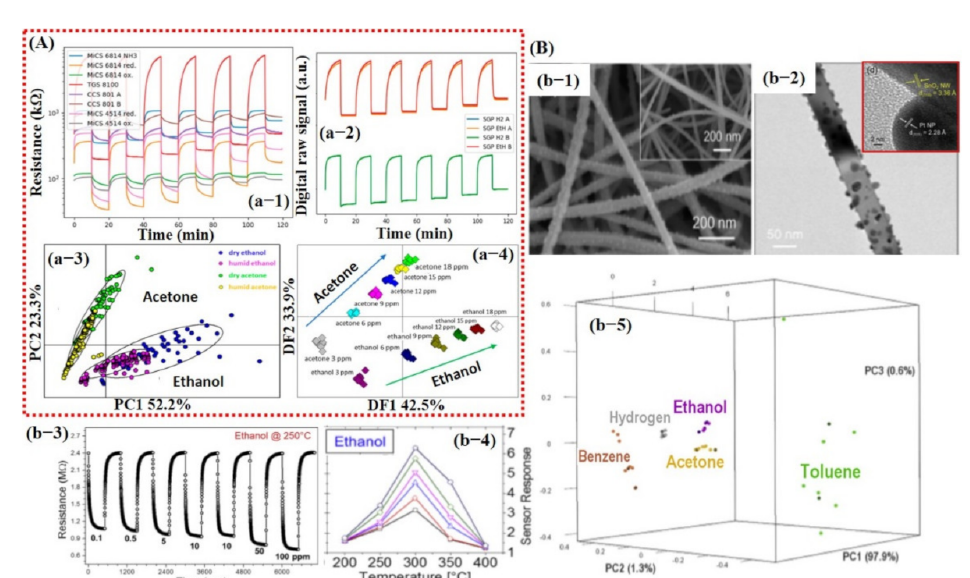
Figure 14. ( A ) e-nose system consisting of analog and digital sensors for detection of different compounds: (a-1) Raw data of analog sensors to acetone under humid conditions. (a-2) Raw data of digital sensors after exposure to acetone under humid conditions. (a-3) PCA score plot showing the effect of humidity. The measurements are labeled by condition and target compound. (a-4) LDA scores plot for the discrimination of compounds and concentrations of the measurements performed under dry and humid conditions. Reproduced with permission from [132], copyright 2019 ACS. ( B ) Smart sensing of different compounds using thermal fingerprints of a single sensor based on Pt NPs@SnO 2 NWs. (b-1) SEM image of Pt NPs decorated on SnO 2 NWs. (b-2) Higher magnified TEM image of single SnO 2 NW decorated with Pt NPs. (b-3) Dynamic response during the exposure of different ethanol concentrations @ 250 ◦ C. (b-4) Sensor response to ethanol at different operating temperatures. (b-5) Three-dimensional plot of the principal components revealing excellent discrimination among different compounds. Reproduced with permission from [133], copyright 2019